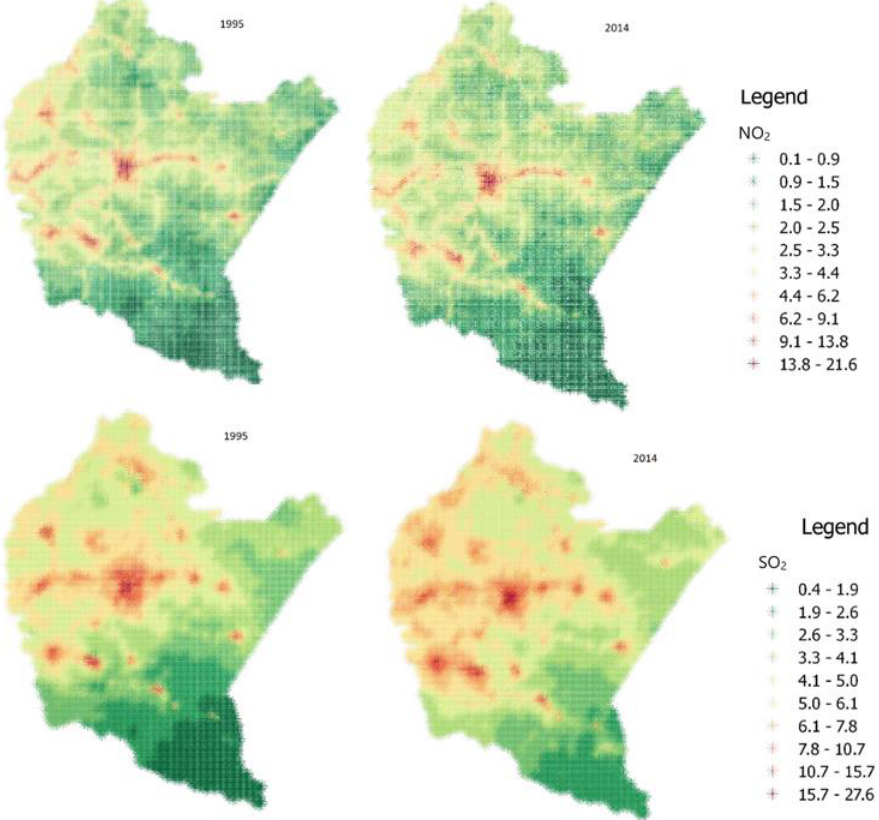
Figure 1. Maps of NO 2 ( µ g/m 3 ) and SO 2 ( µ g/m 3 ) pollutants in 1995 and